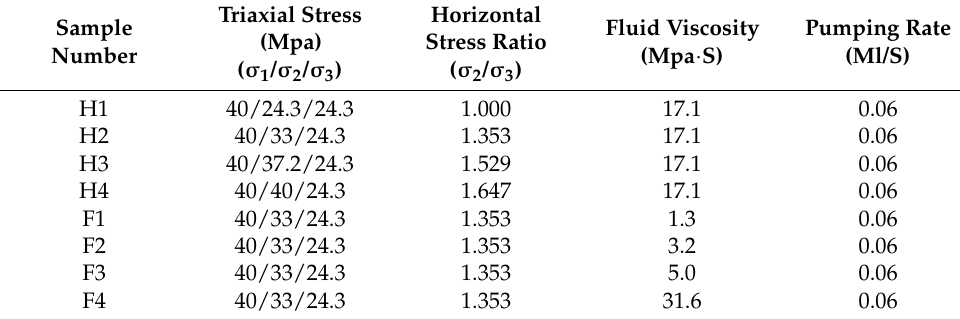
Table 2. Experimental